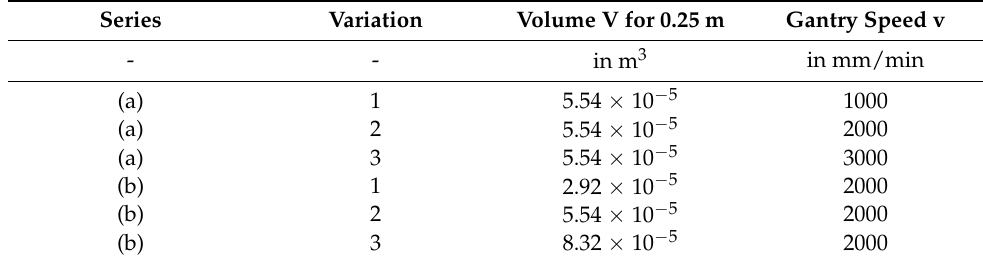
Table A2. Varied process parameters in the penetration depth tests.